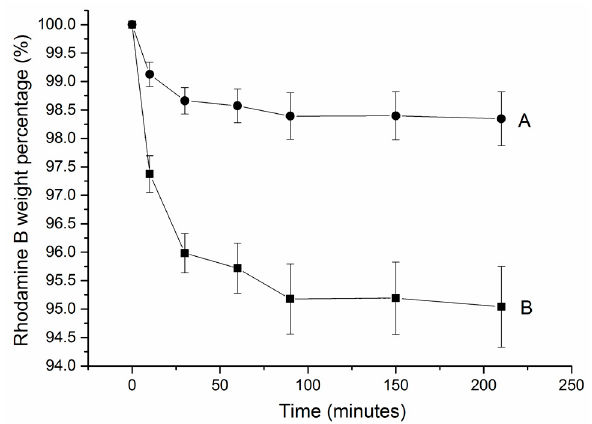
Figure 5. Rhodamine B degradation profile (average and standard deviation) via ( A ) at-home gel and ( B ) in-office gel. Each 0.5 g gel was placed in 10 mL 0.5 M rhodamine B solution for 250 min. For each gel, n = 3.